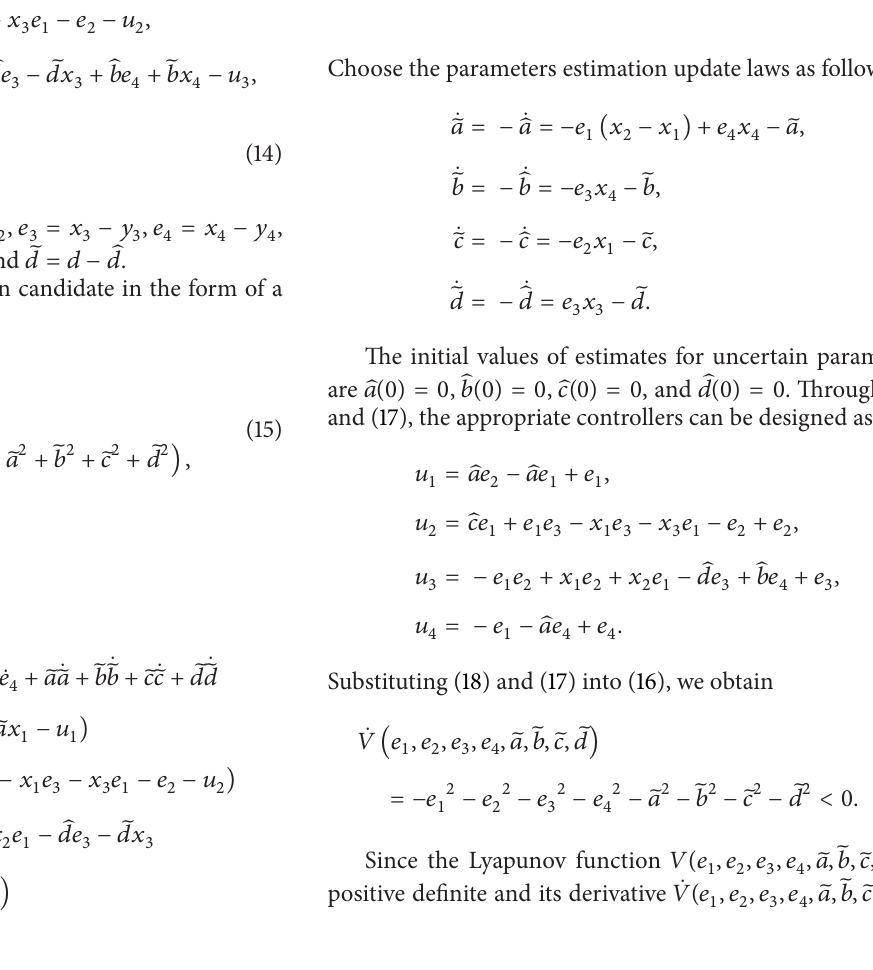
From the error functions, we get the error dynamics ̇𝑒 = ̂𝑎𝑒 + ̃𝑎𝑥 − ̂𝑎𝑒 − ̃𝑎𝑥 − 𝑢 1 2 2 1 1 1